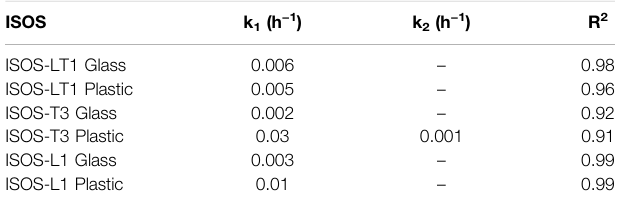
TABLE 6 | Degradation constants obtained from the exponential fi t for glass and plastic in the different degradation systems. ISOS k 1 (h − 1 ) k 2 (h − 1 ) R 2